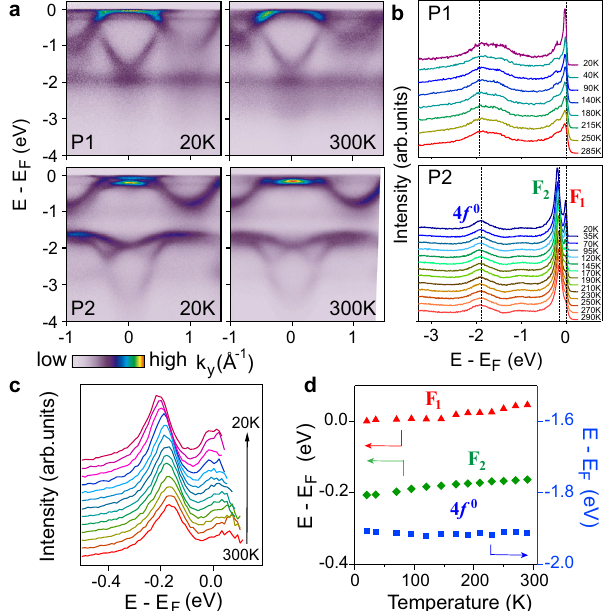
Fig. 3 Constant energy contours for the P1 and P2 phases. a , b Constant energy contours at E = 0 (i.e., the FS), − 0.2 and − 0.4 eV for P1 ( a ) and P2 ( b ) at 20 K. c Constant energy contours for P2 at 300 K. The Brillouin zone is indicated by the cyan